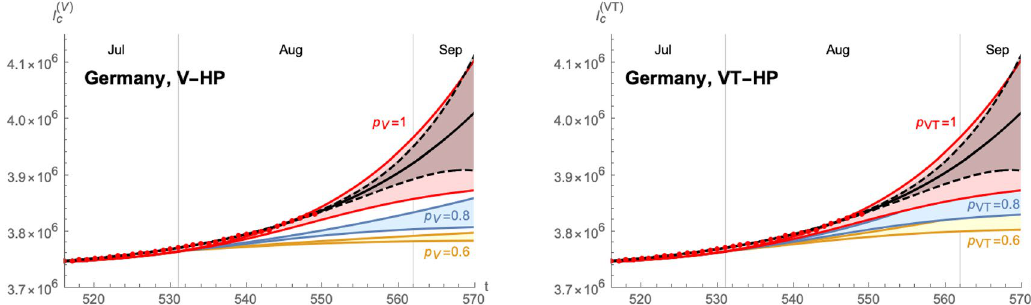
Figure 8. Time evolution of the cumulative number of infected individuals for different values of the efficacy of a V-HP (right panel) or a VT-HP (right panel). We assume that the model has been introduced on 01/08/2021. Both cases use ζ = 0.15 (based on an average of the efficacy of each vaccine weighted by the distribution among the population), ρ = 0.008 and σ 2 /σ 1 = 1 .